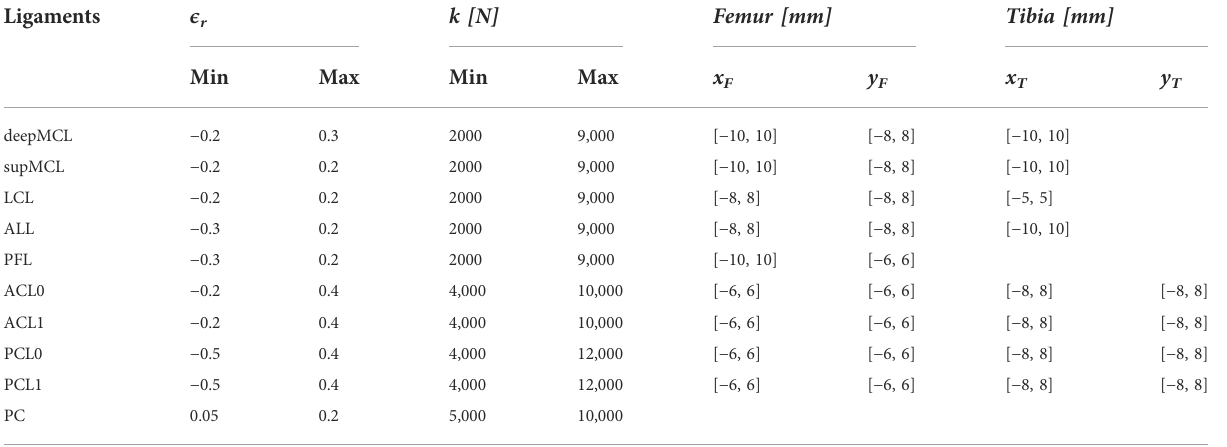
TABLE 2 Training bounds of the ANN for the ligament material properties.